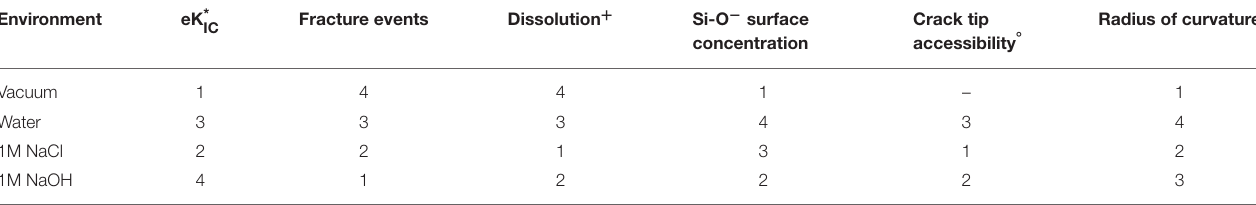
TABLE 3 | Ranking of factors that influence environmentally assisted fracture from highest (1) to lowest (4).